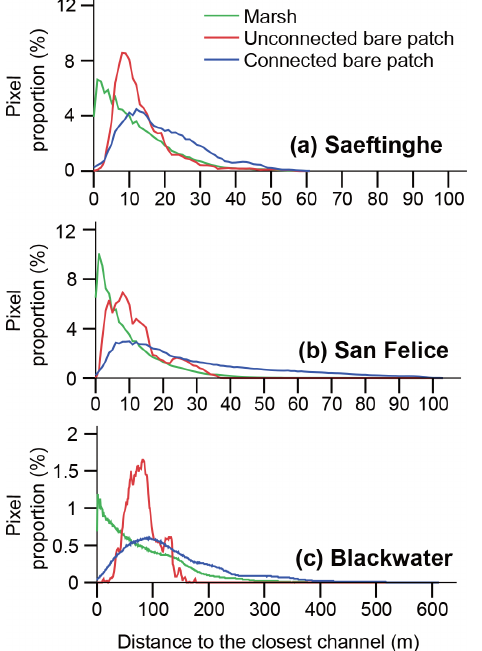
Figure 5. Frequency distribution of distances to the closest channel in (a) Saeftinghe, (b) San Felice, and (c) Blackwater. The proportion is calculated as the number of pixels in each distance class (every 1m) relative to the total number of pixels for each category, i.e., vegetated marshes, unconnected bare patches, or connected bare patches.